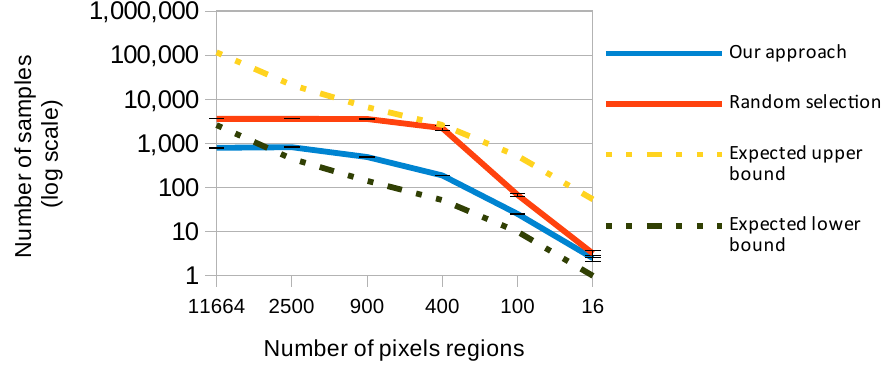
Figure 7. Number of samples needed until all features were